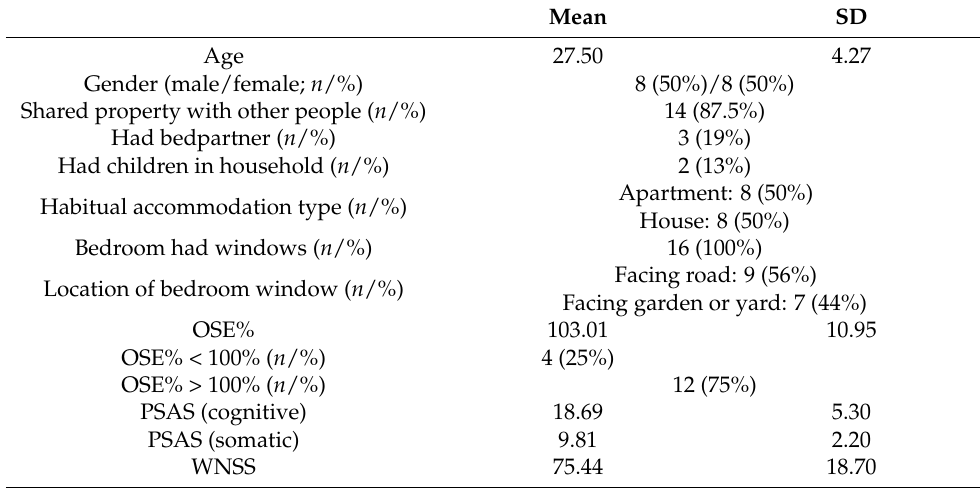
Table 1. Participant demographics ( n = 16).